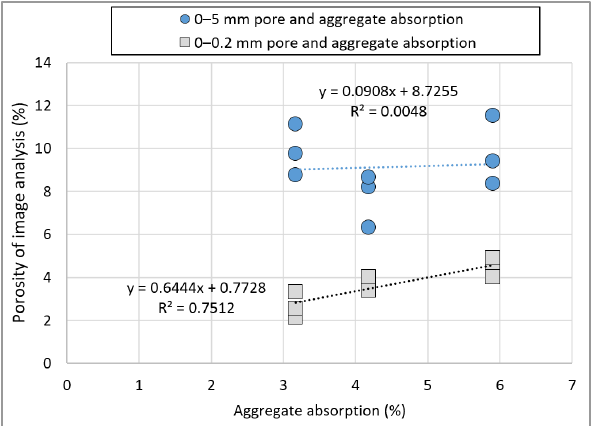
Figure 16. Relationship between the aggregate absorption and porosity.